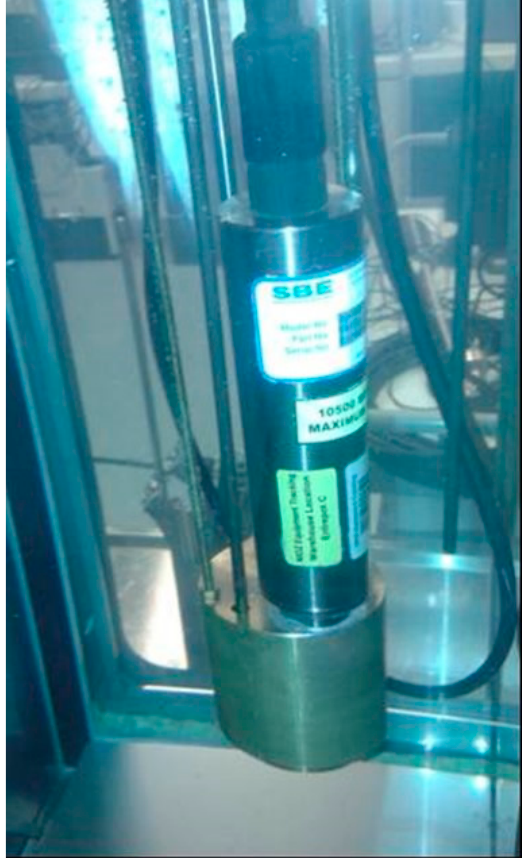
Figure 4. SBE3 , SBE35 (not visible), and two reference SPRTs mounted in the brass comparator Figure 4. SBE3, SBE35 (not visible), and two reference SPRTs mounted in the brass comparator block block of the sub-millikelvin calibration facility. of the sub-millikelvin calibration